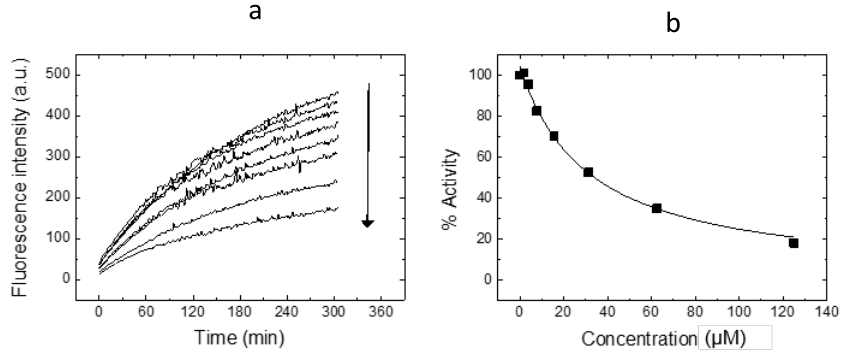
Figure 4. Inhibition curve for RutinArg against Mpro. ( a ) Time evolution of the substrate fluorescence as a function of time. The observed FRET diminishes as the substrate is hydrolyzed by Mpro, reflecting the spatial separation of the donor-acceptor FRET couple. As the RutinArg concentration increases (arrow), the activity of Mpro, quantitated as the initial slope of each trace, decreases. ( b ) Inhibition curve obtained by plotting the activity percentage of Mpro, calculated as the ratio of the initial slope at each RutinArg concentration by that corresponding to no compound added (control), as a function of the RutinArg concentration. The non-linear least-squares analysis of the data considering a ligand-depletion model provided an estimation of the inhibition constant K i . When the enzyme concentration and the ligand depletion are not accounted for, the effective inhibition concentration IC 50 is estimated.